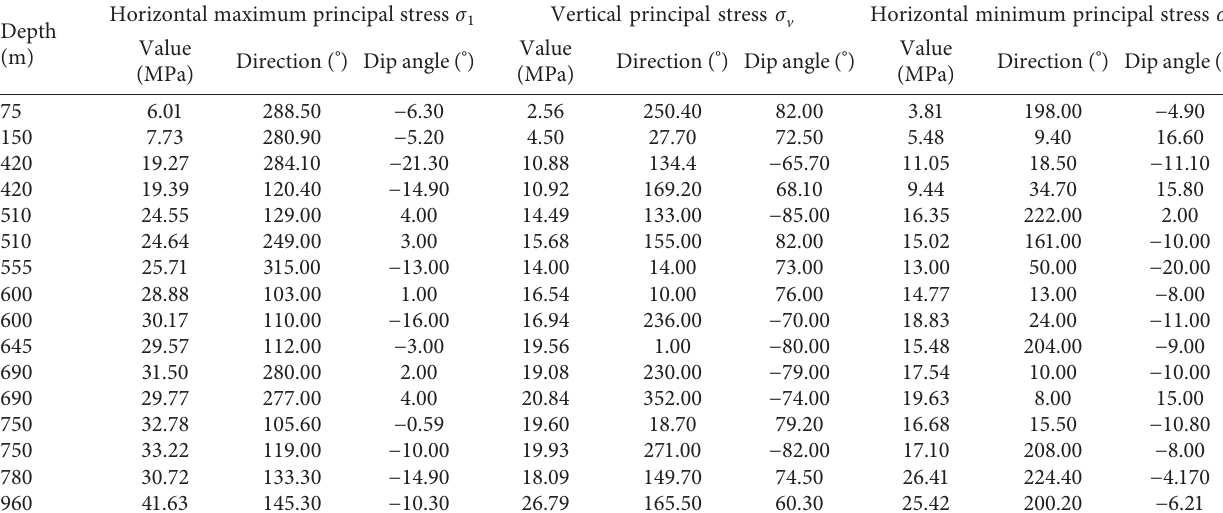
Table 2: The results of the in situ stress measurement at depths of 75–750m.